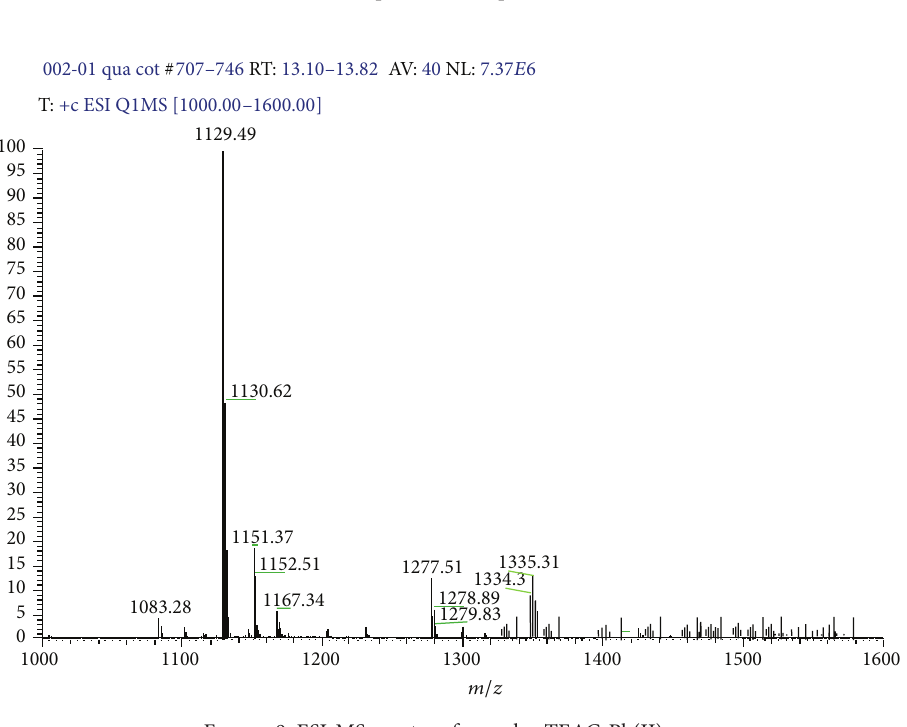
Figure 8: ESI-MS spectra of complex TEAC-Cr(III).